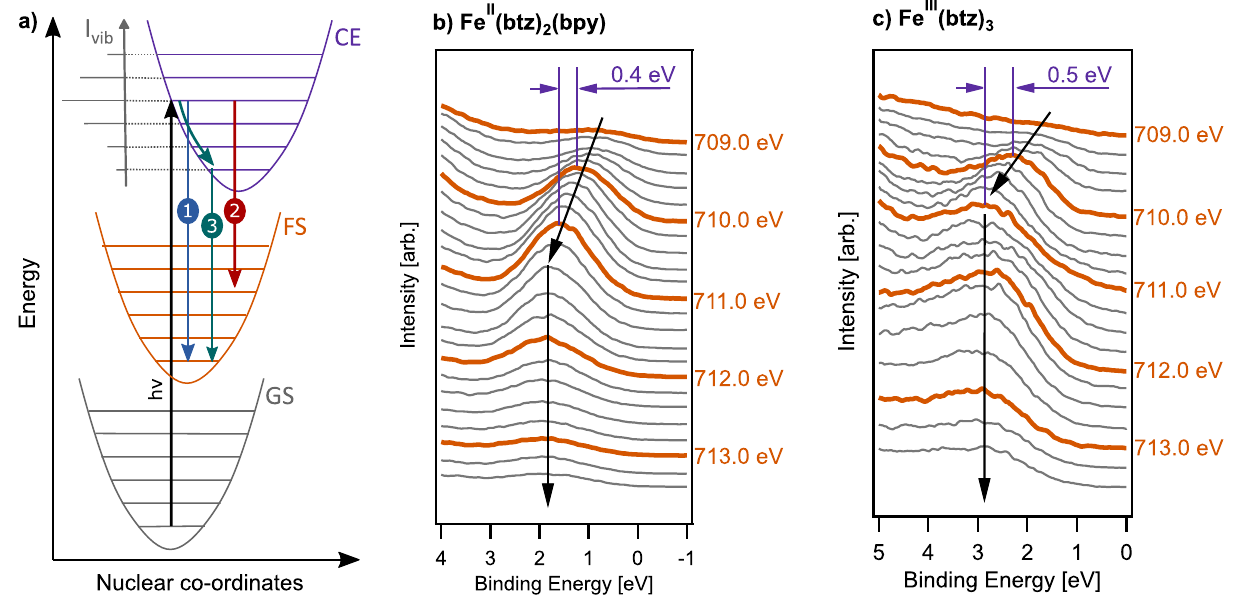
Figure 10. Scheme and evidence of vibronic coupling observed in the Fe 2 p 3 / 2 RPES data of both FeNHC complexes (a) Simplified Franck–Condon diagram highlighting the different relaxation possibilities after excitation into higher vibrational modes in the core-excited intermediate state. GS ground (initial) state, CE core excited intermediate state, FS final state. (b , c) show the binding energy evolution of the t 2g derived HOMO as a function of photon energy over the Fe 2 p 3 / 2 → e g resonance for [ Fe II ( btz ) 2 ( bpy ) ] 2 + and [ Fe III ( btz ) 3 ] 3 +